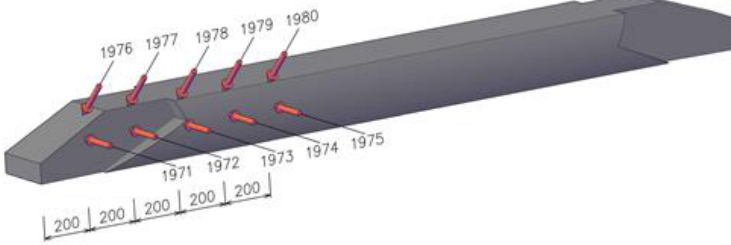
Figure 22. Marking of the points measured by Resistograph, beam (I2).